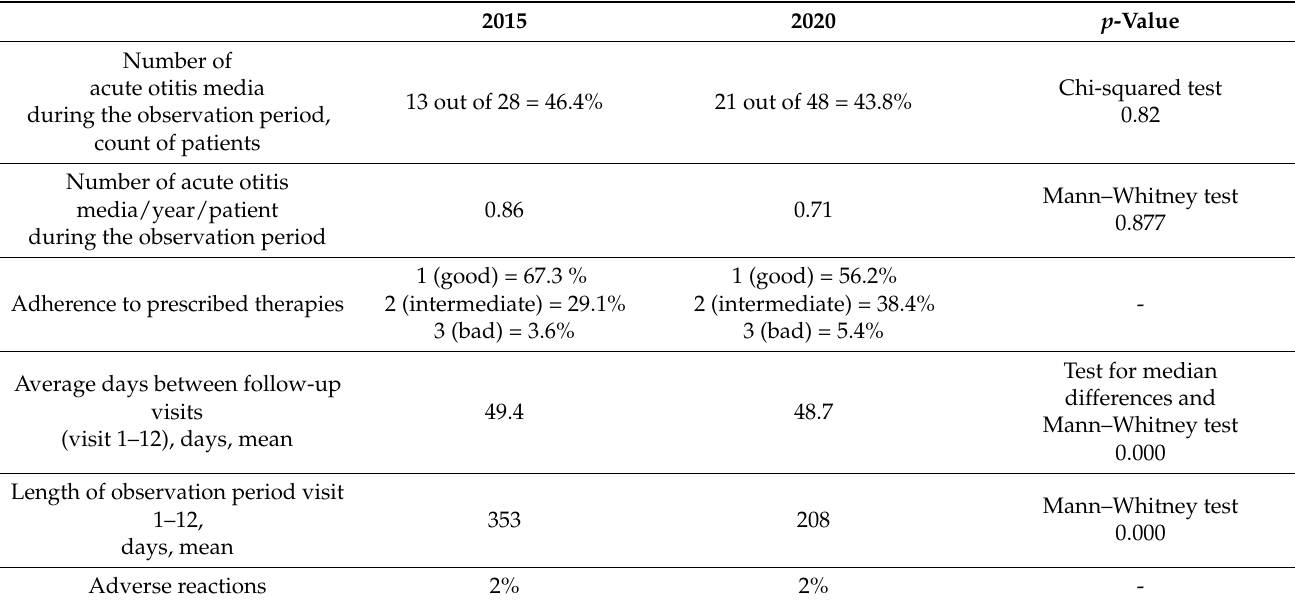
Table 5. Results of secondary outcome variables.